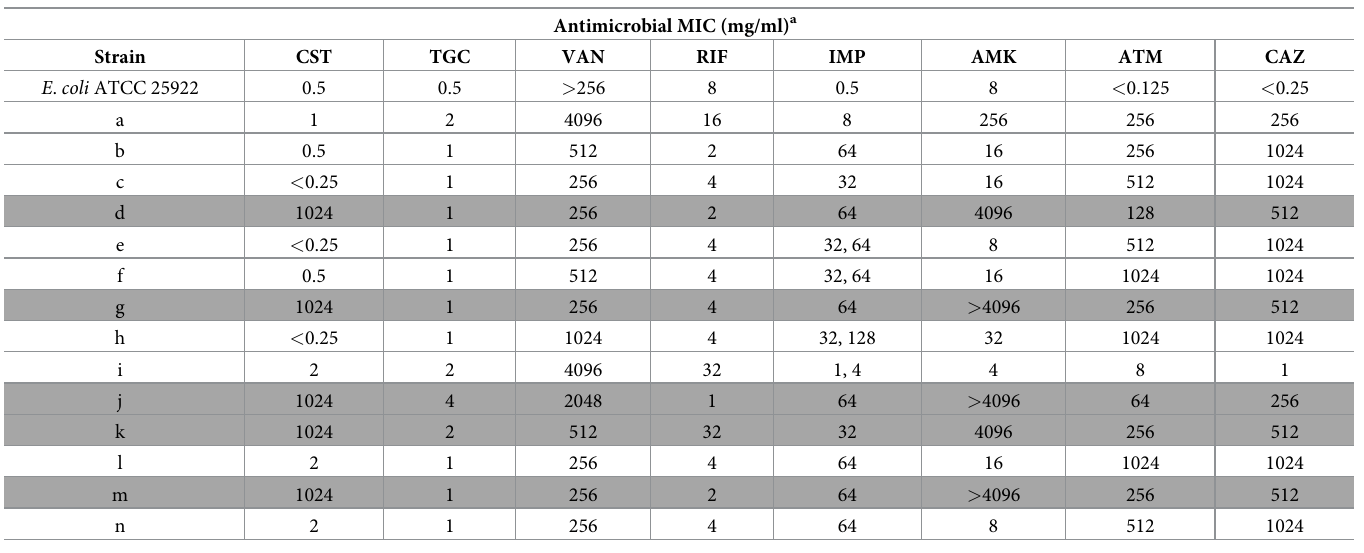
Table 2. Antimicrobial agents MIC with colistin-resistant A . baumannii clinical isolates.